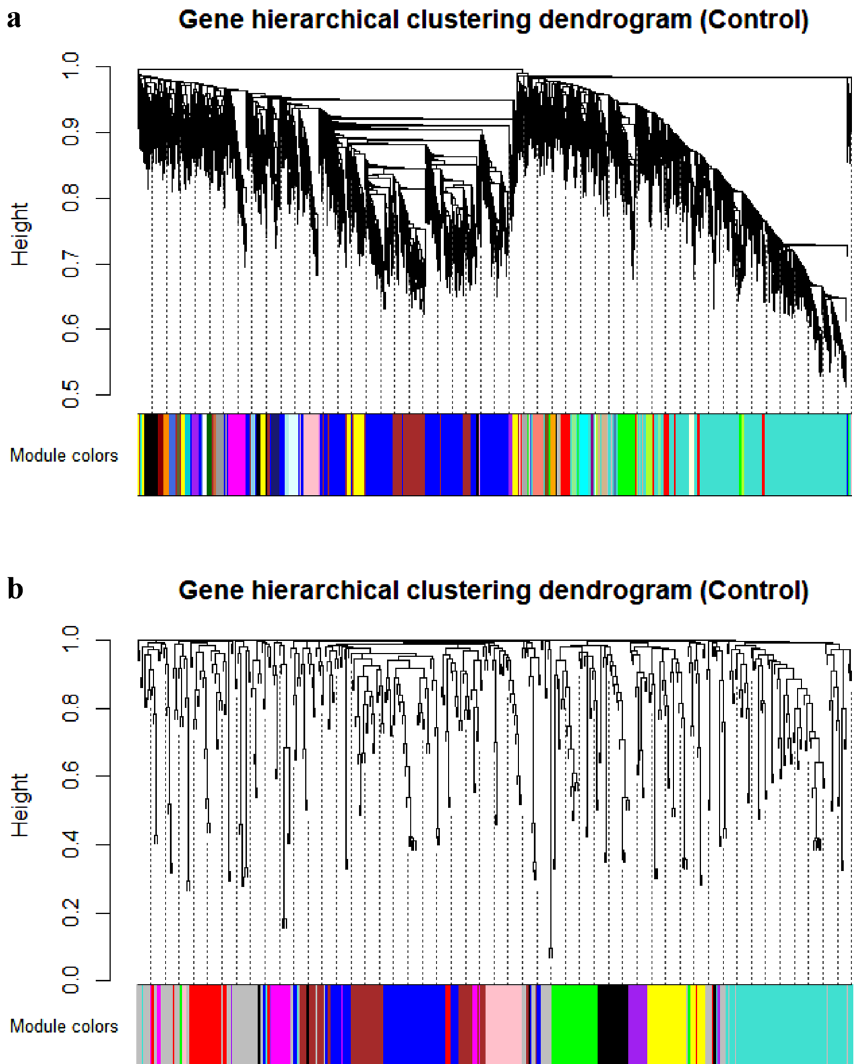
Figure 2. Clustering dendrogram of mRNAs and lncRNAs ( a ) and miRNAs ( b ). In WGCNA genes are clustered into modules based on their co-expression. Hierarchical clustering is a widely used method for detecting clusters. The co-expressed genes have a small degree of dissimilarity. The dissimilarity measure (1-TOM) can be used as input in hierarchical clustering. Following that, modules were defined as branches of a cluster tree and each module was labeled by a unique color using the static tree cutting